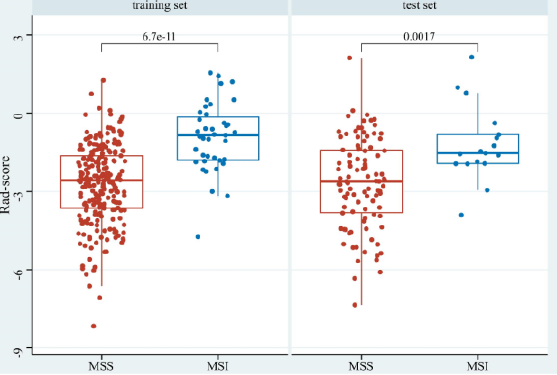
Figure 6. The boxplot of rad-scores of MSS and MSI in the training and test sets.